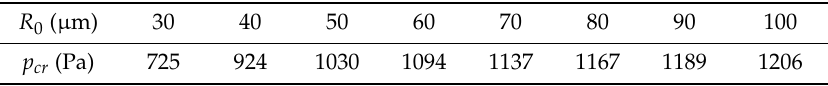
Table 2. Critical pressure according to initial nuclei